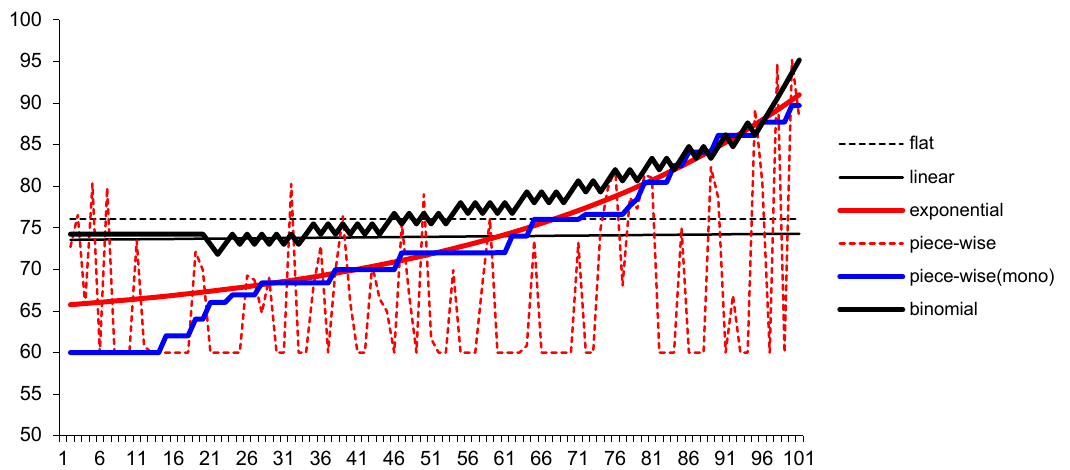
Figure 3. Various exercise boundaries.